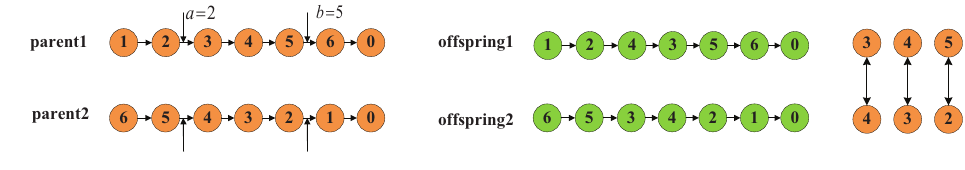
Figure 4. The crossover process in the GA-LNS algorithm.